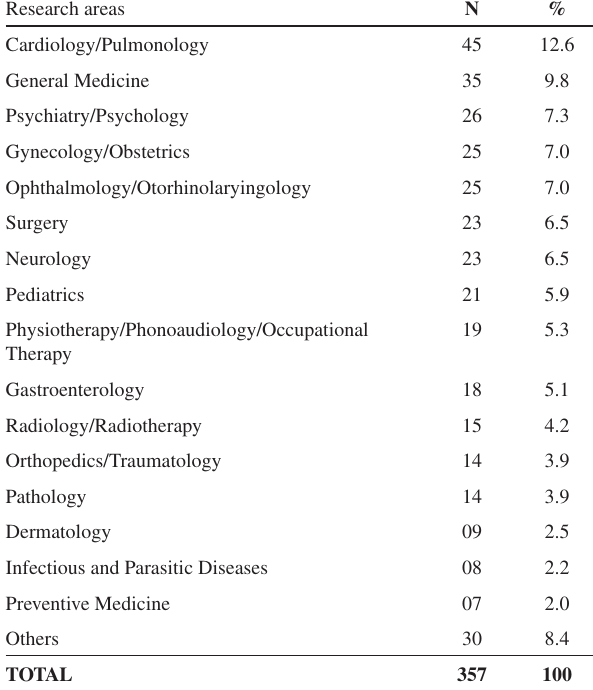
Table 1 - Research areas